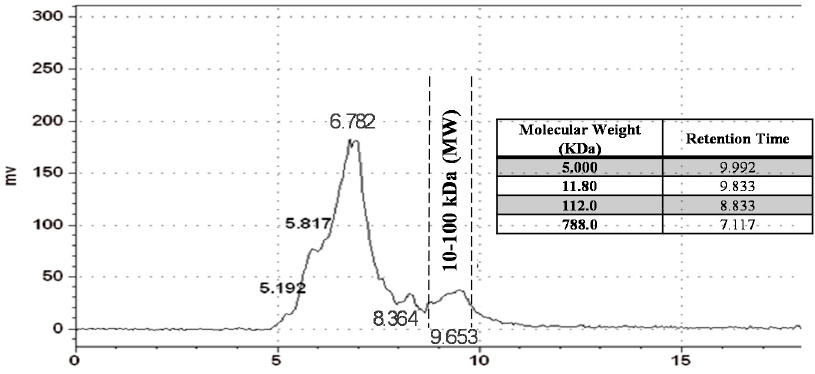
Figure 1. Profile of the molecular weight distribution of crude IOP extract by gel permeation chromatography analysis.2.2. Effect of Inonotus obliquus Polysaccharides (LIOP) on the Glucose chromatography Tolerance Test (OGTT) in C57BL/6 Mice.